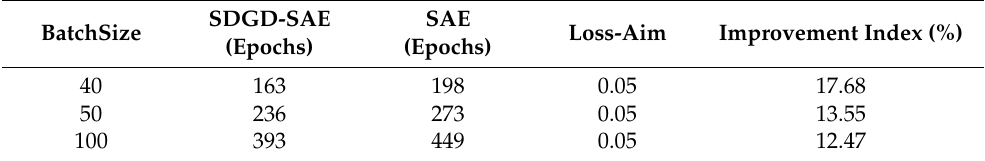
Table 10. Convergence speed